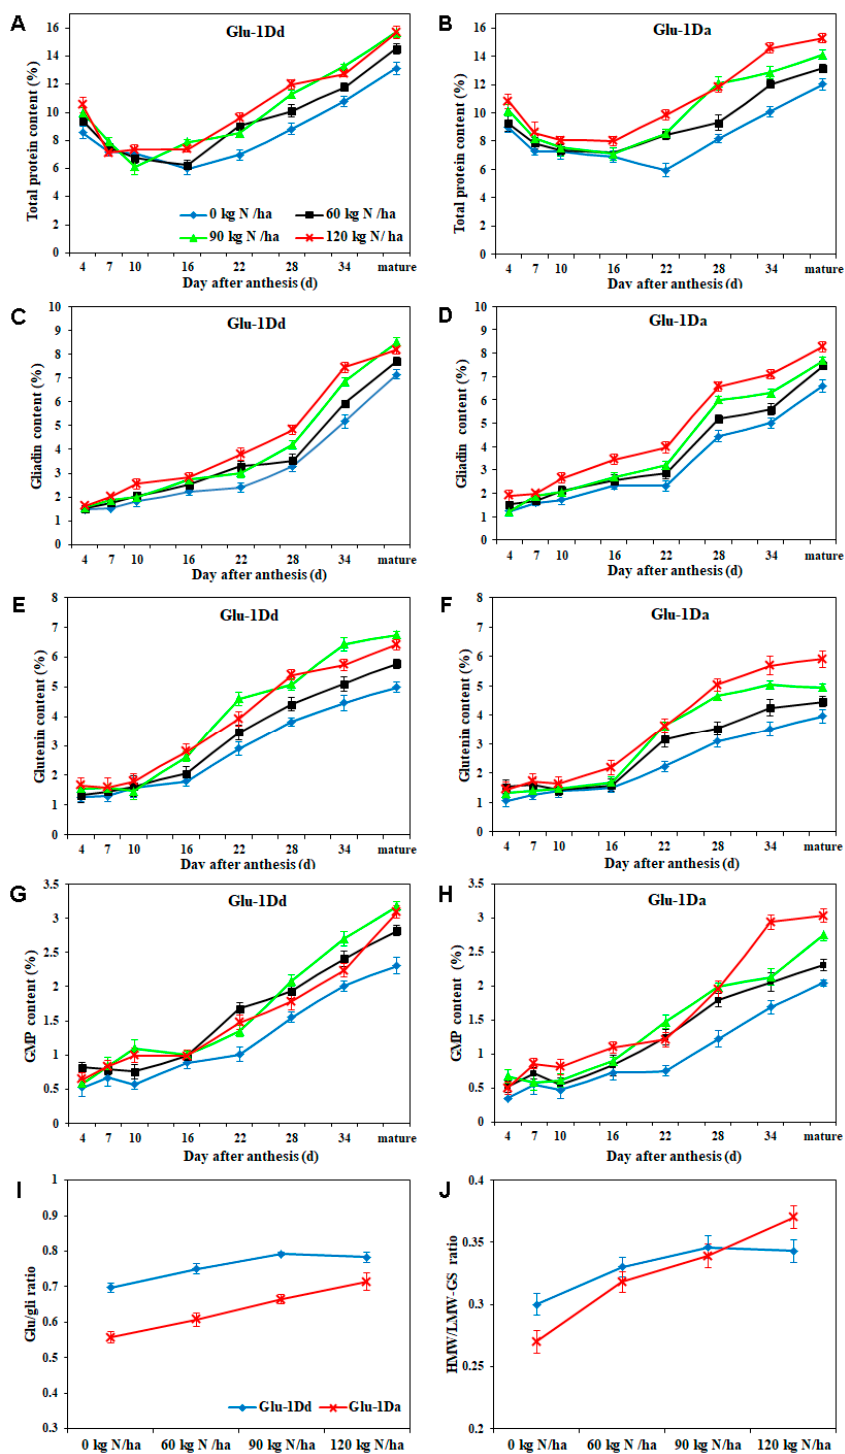
Figure 2. Dynamic accumulation of total protein and its compositions during grain development ( A - H ) and maturity ( I , J ) for wheat lines with Glu-1Dd and Glu-1Da under the application of N fertilizer. ( A , B ), total protein content; ( C , D ), gliadin content; ( E , F ), glutenin content; ( G , H ), glutenin macropolymer (GMP) content; ( I ), Glu / gli ratio (ratio of glutenin to gliadin content); ( J ), HMW / LMW-GS ratio (Ratio of HMW-GS to LMW-GS content). Data are presented as the mean of two years. Data of significant di ff erence were analyzed statistically at a level of